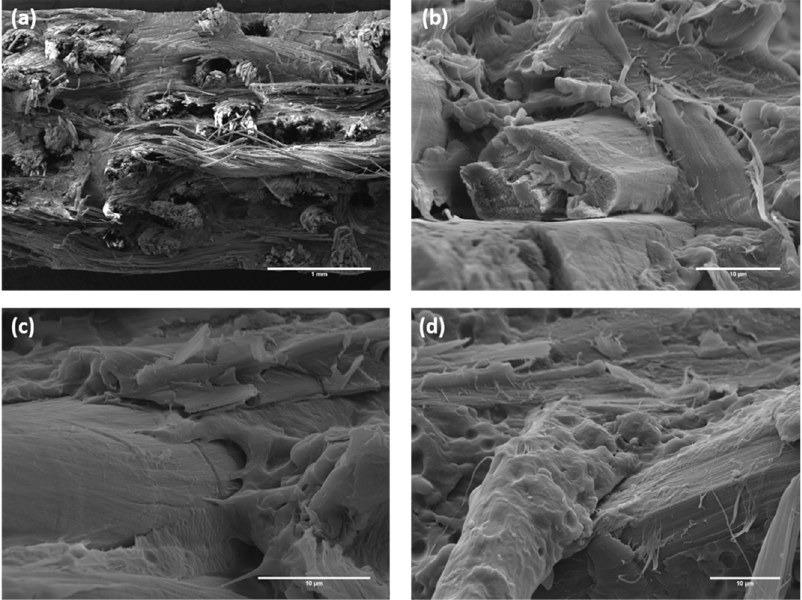
Figure 6. SEM micrographs of the fracture surface of PPC (PP modified with coupling agent) / Flax composites at different magnifications.